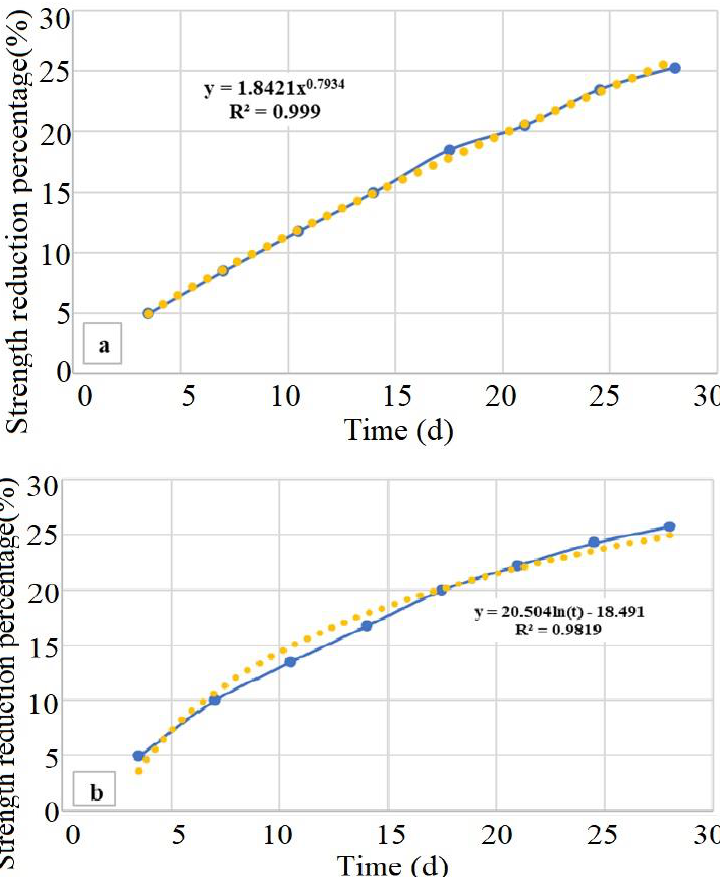
Figure 7. Reduction rate of tensile strength. ( a ) Metamorphic quartz sandstone and ( b ) slate.